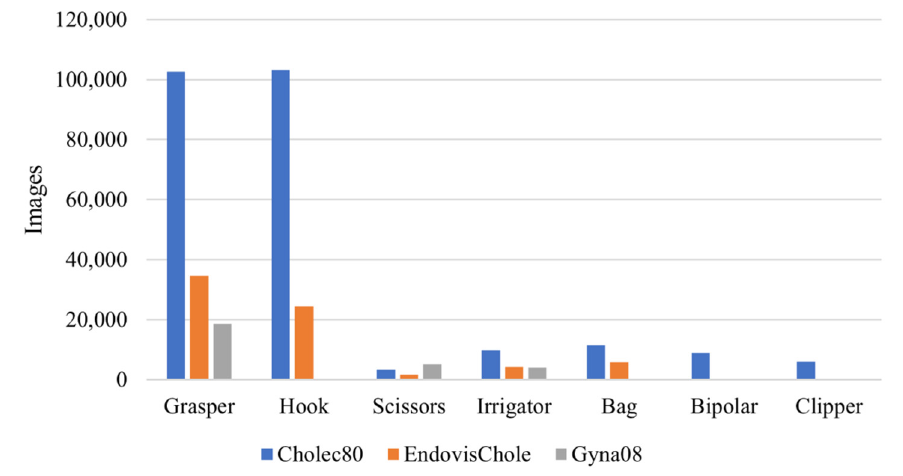
Figure 2. Distribution of surgical tools in Cholec80, EndovisChole, and Gyna08 datasets. Table 1. Mean and standard deviation of the percentage of tool usage in procedures in the Cholec80, EndovisChole, and Gyna08 datasets.